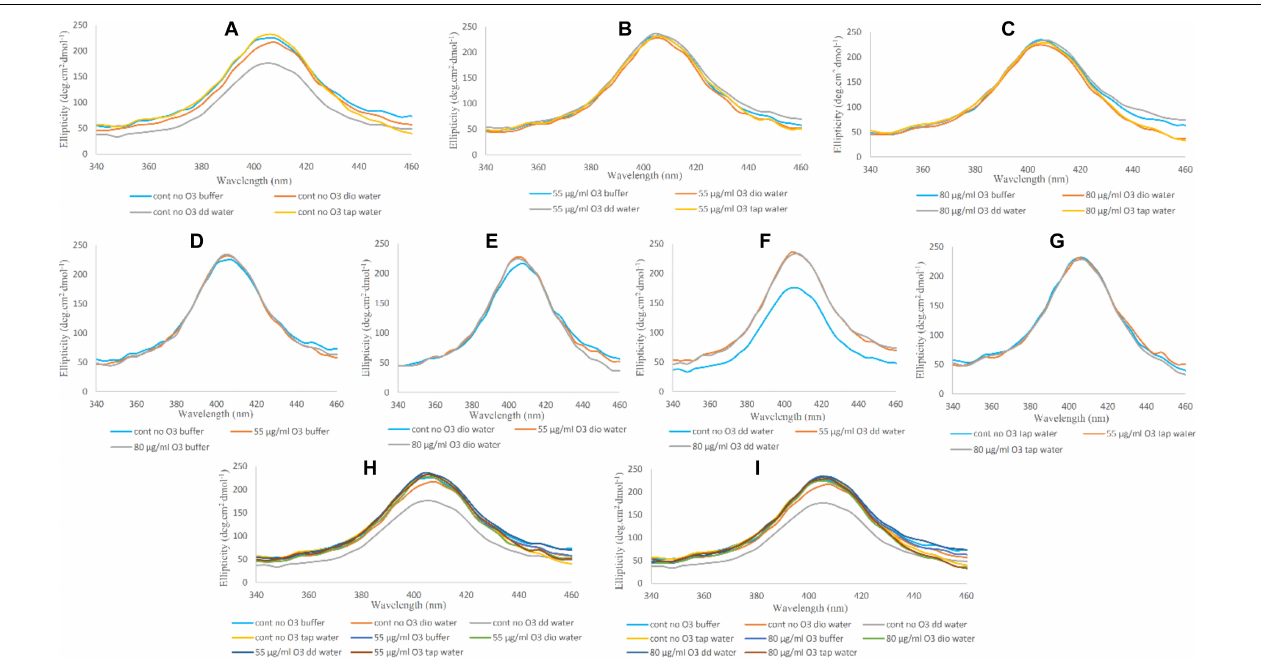
FIGURE 5 | Soret-UV CD spectra of non-ozonated and ozonated Hb samples in the presence of phosphate buffer and diluted versions with different water types. (A) Non-ozonated Hb in phosphate buffer and different water types. (B) Hb ozonated with 55 µ g/ml ozone in phosphate buffer and different water types. (C) Hb ozonated with 80 µ g/ml ozone in phosphate buffer and different water types. (D) Non-ozonated and ozonated Hb with 55 and 80 µ g/ml ozone in phosphate buffer. (E) Non-ozonated and ozonated Hb with 55 and 80 µ g/ml ozone in phosphate buffer diluted with deionized (Dio) Water. (F) Non-ozonated and ozonated Hb with 55 and 80 µ g/ml ozone in phosphate buffer diluted with double distilled (DD) Water. (G) Non-ozonated and ozonated Hb with 55 and 80 µ g/ml ozone in phosphate buffer diluted with Tap Water. (H) Non-ozonated and ozonated Hb with 55 µ g/ml ozone in phosphate buffer and diluted in various different water types. (I) Non-ozonated and ozonated Hb with 80 µ g/ml ozone in phosphate buffer and diluted in various different water